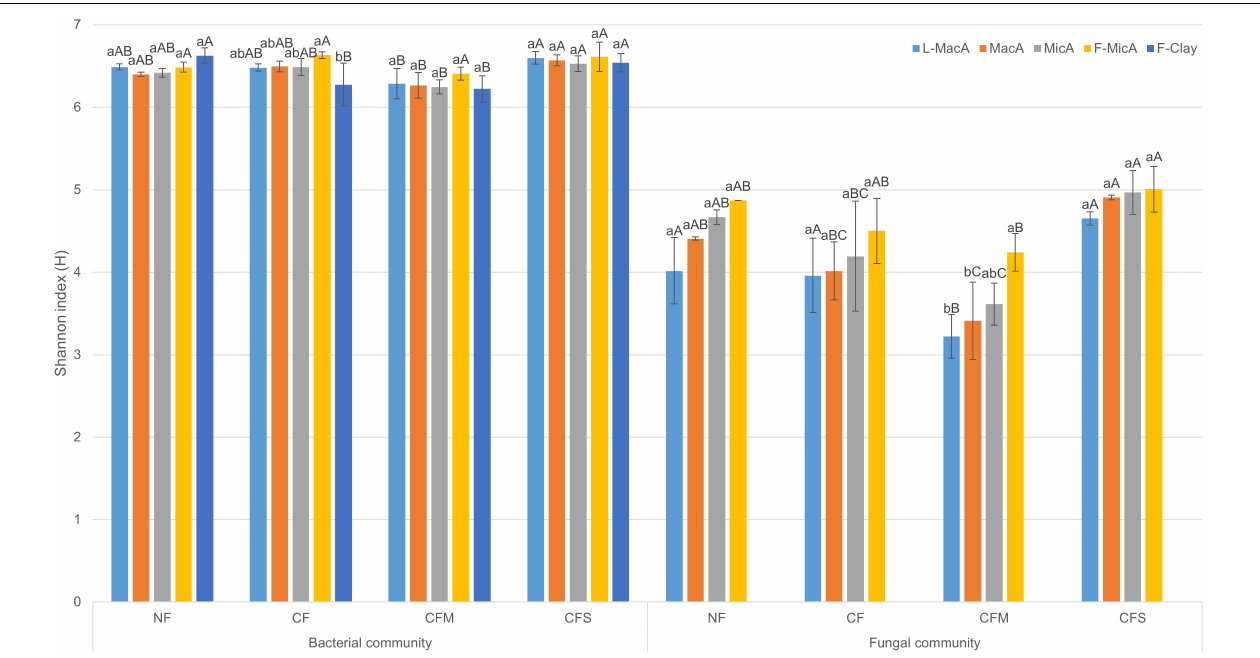
FIGURE 1 | Shannon index (H) (mean ± SD, n = 3) of bacterial and fungal communities in aggregate-size fractions under treatments. Different lowercase and uppercase letters represent significant ( p < 0.05) difference among aggregate-size fractions and treatments, respectively. NF, no fertilizer applied; CF, compound inorganic fertilizer; CFM, inorganic fertilizer combined with swine manure; CFS, inorganic fertilizer combined with residue return. L-MacA, > 2,000 µ m; MacA, 2,000–250 µ m; MicA, 250–53 µ m; F-MicA, 53–2 µ m; F-Clay, < 2 µ m.